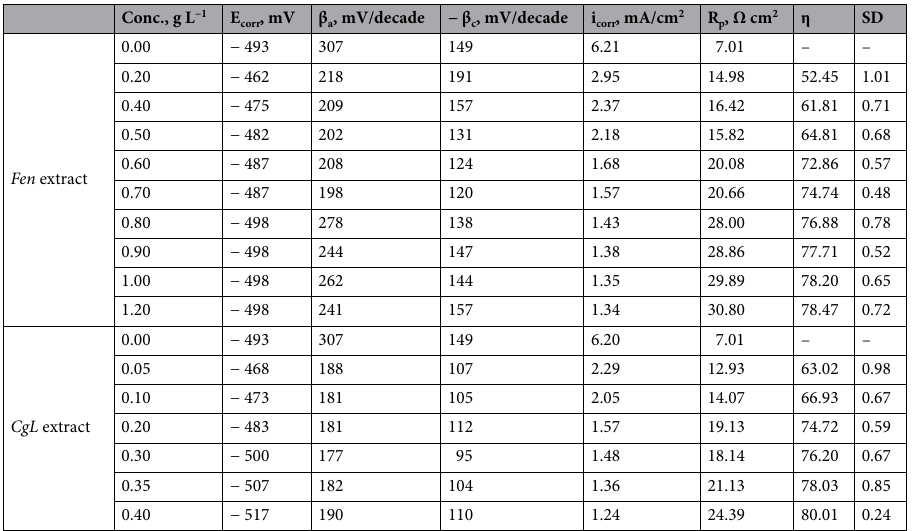
Table 2. Electrochemical polarization parameters of steel in 20% phosphoric acid in the absence and presence of Fen and CgL